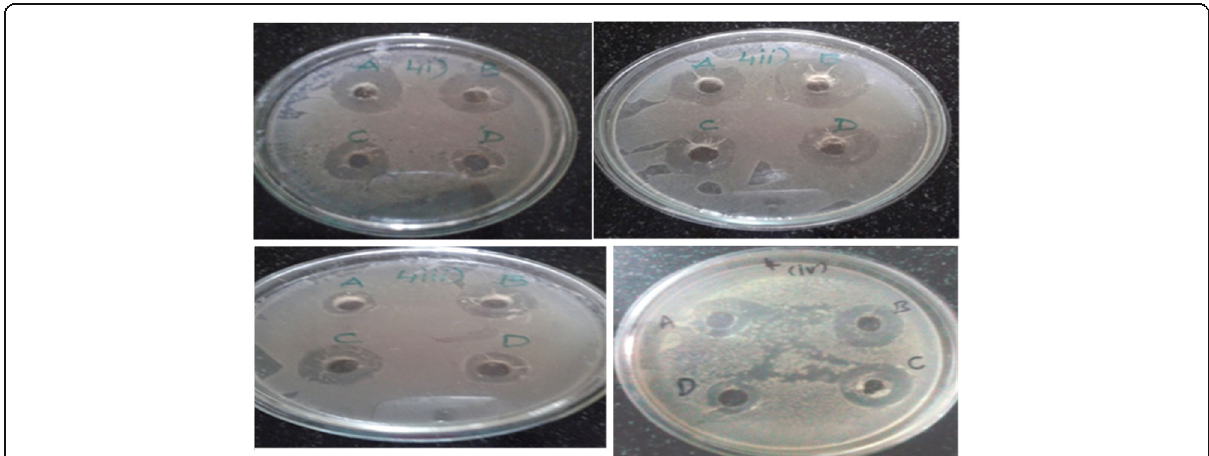
Fig. 1 Represents diameter of zone of inhibition of ion exchange chromatography elutes from Cucumis sativus .L seeds [i] S. aureus (ATCC 25923), [ii] E. coli (ATCC 25922), [iii] P. aeruginosa (ATCC 27853) and)[iv] P. vulgaris (ATCC 6380. Elute 1[A],Elute 2[B], Elute 3[C] and Elute